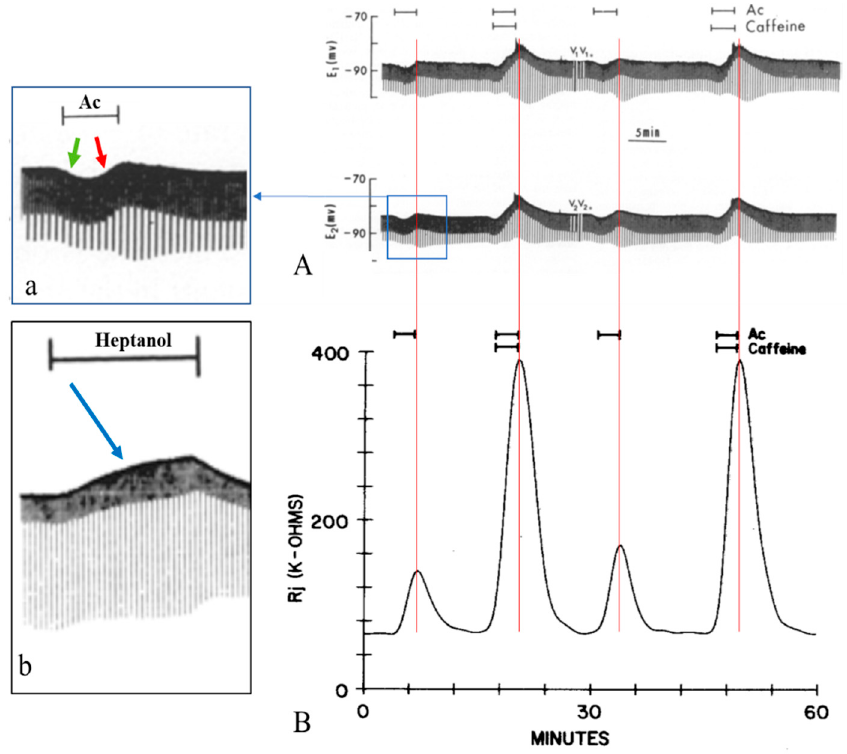
Figure 11. Time course of electrotonic potentials and Rj in crayfish septate axons uncoupled by acetate (Ac) in the presence and absence of 10 mM caffeine ( A , B ). ( A ). Low-speed chart recording of membrane and electrotonic potentials. With Ac, V 1 and V 2 * increase and V 1 * and V 2 decrease ( A ), reflecting an increase in Rj ( B ). Ac-caffeine causes a larger change in electrotonic potentials ( A ), indicating a larger increase in Rj ( B ). Note that Rj increases with Ac-caffeine 3–4 times as much as with Ac alone ( B ). With Ac or Ac-caffeine, there is a biphasic change in the membrane potential: a moderate hyperpolarization followed by depolarization (( A ), and inset a, green and red arrows, respectively). In contrast, with heptanol, there is only depolarization (inset b, blue arrow, and Figures 2A and 3A). A, B and inset a were adapted from [20]. Inset b was adapted from [16].